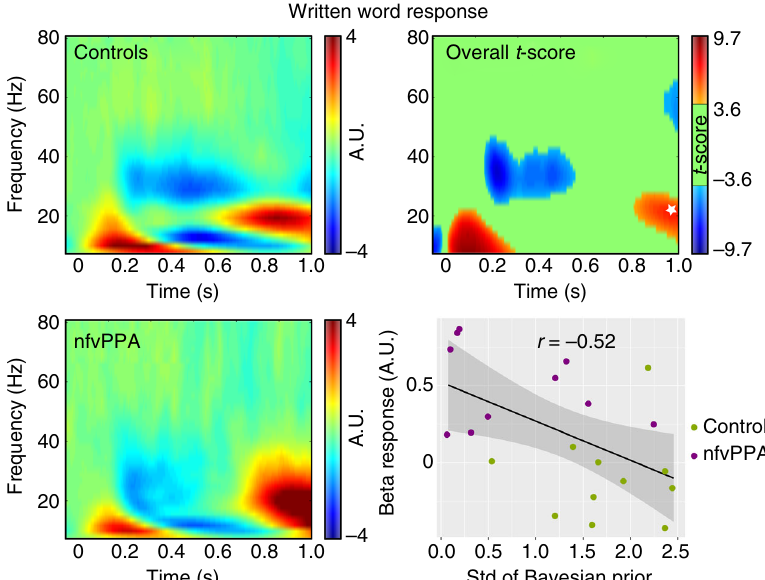
Fig. 6 Analysis of induced responses after the written but before spoken word. Total induced power after written word onset by group, the overall t -score for difference from baseline for both groups combined, and the relationship between single subject response at the late beta peak (indicated by a white star) and precision of their prior expectations in the Bayesian behavioural model. A.U., arbitrary units. The grey shaded area in the bottom right plot indicates the 95% con fi dence band for the regression line, marked in